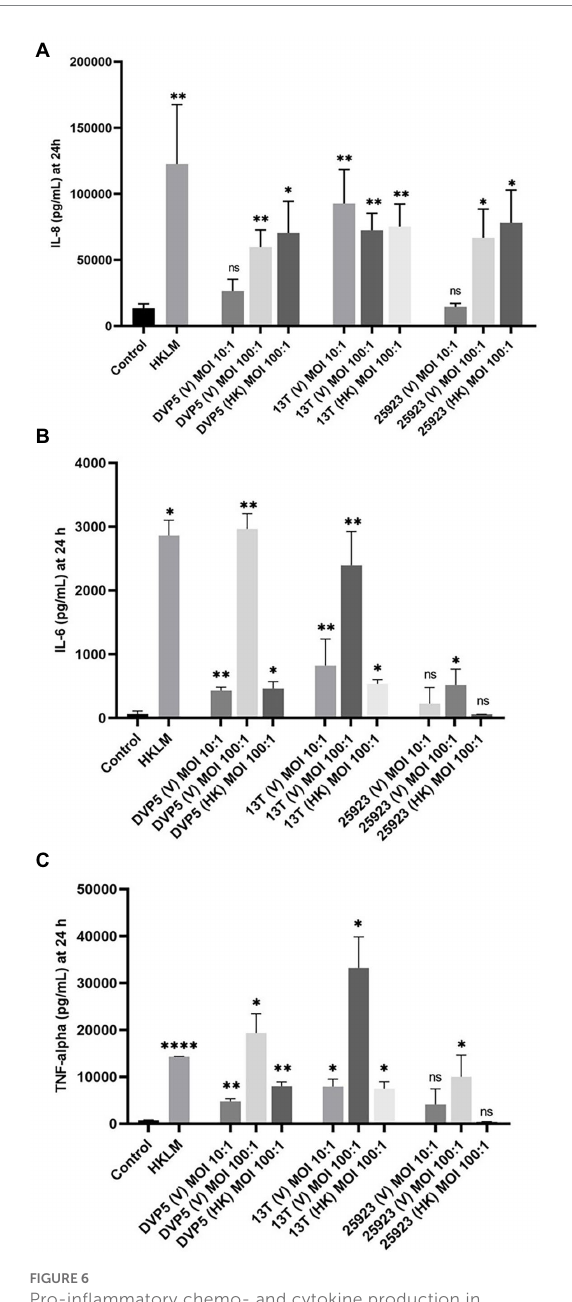
FIGURE 6 Pro-inflammatory chemo- and cytokine production in macrophage-like cells triggered by S. saccharolyticus . THP-1 cells were differentiated and exposed to the S. saccharolyticus strains DVP5-16-4677 (DVP5) and 13 T0028 (13 T) as well as to S. aureus ATCC 25923. Cell supernatants were harvested after 24 h and levels of the chemo- and cytokines IL-8 (A) , IL-6 (B) , TNF-alpha (C) were determined. Viable (V) bacteria were tested at two MOIs (10, 100) and heat-killed (HK) bacteria were tested at MOI 100. Heat-killed Listeria monocytogenes (HKLM) as a well-studied TLR-2 agonist was used as a positive control. Results are expressed as mean ± SEM, and significant differences compared to untreated cells are highlighted by asterisks (*, p < 0.05; **, p < 0.01; ****, p < 0.0001; ns, not significant; Welch’s t -test for parametric distribution data and Mann–Whitney test for non- parametric distribution data were